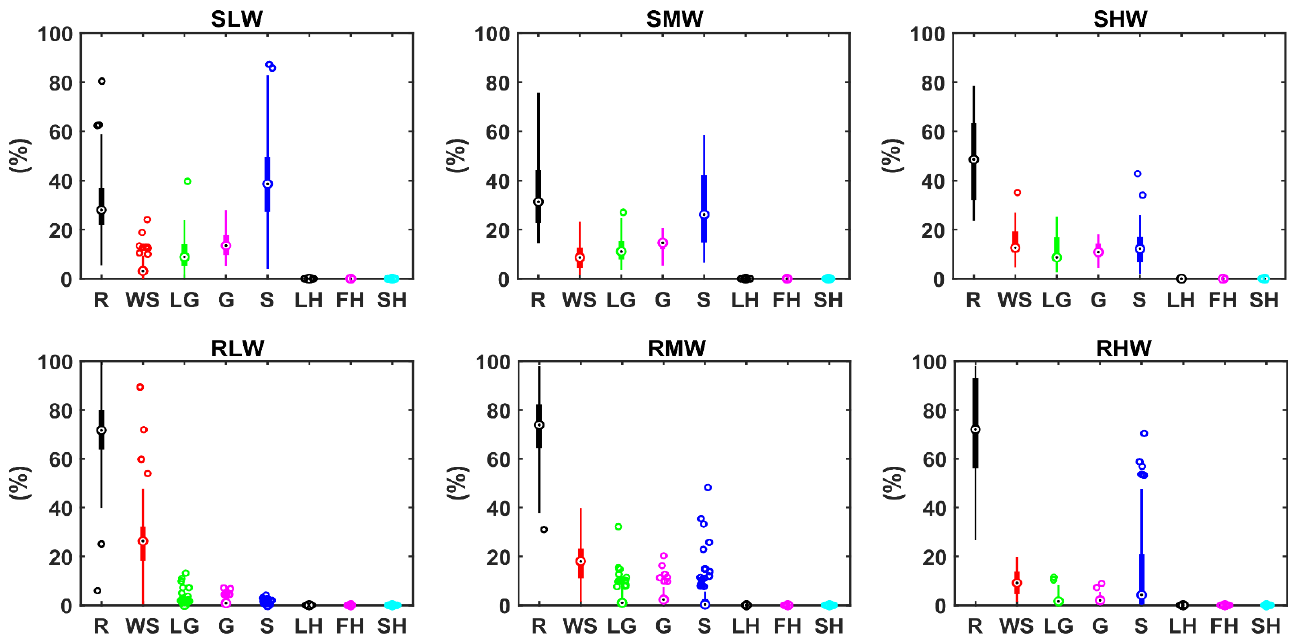
Figure 8. Boxplot of contribution (%) of each type of hydrometeor in solid and liquid precipitation groups. The acronyms represent: raindrops (R), wet snow (WS), lump graupel (LG), graupel (G), snow (S), lump hail (LH), fresh hail (FH), and soft hail (SH). Table 8. Coefficient of correlation ( r 2 ), RMSE , relative difference ( Diff ) and accumulated ratio ( Ac r ) between corrected precipitation following the five density models and TPB precipitation for 15, 30, and 60 min timescales. Scores are displayed for low ( RLW ), moderate ( RMW ), and high wind speed ( RHW ) groups and for all liquid precipitation